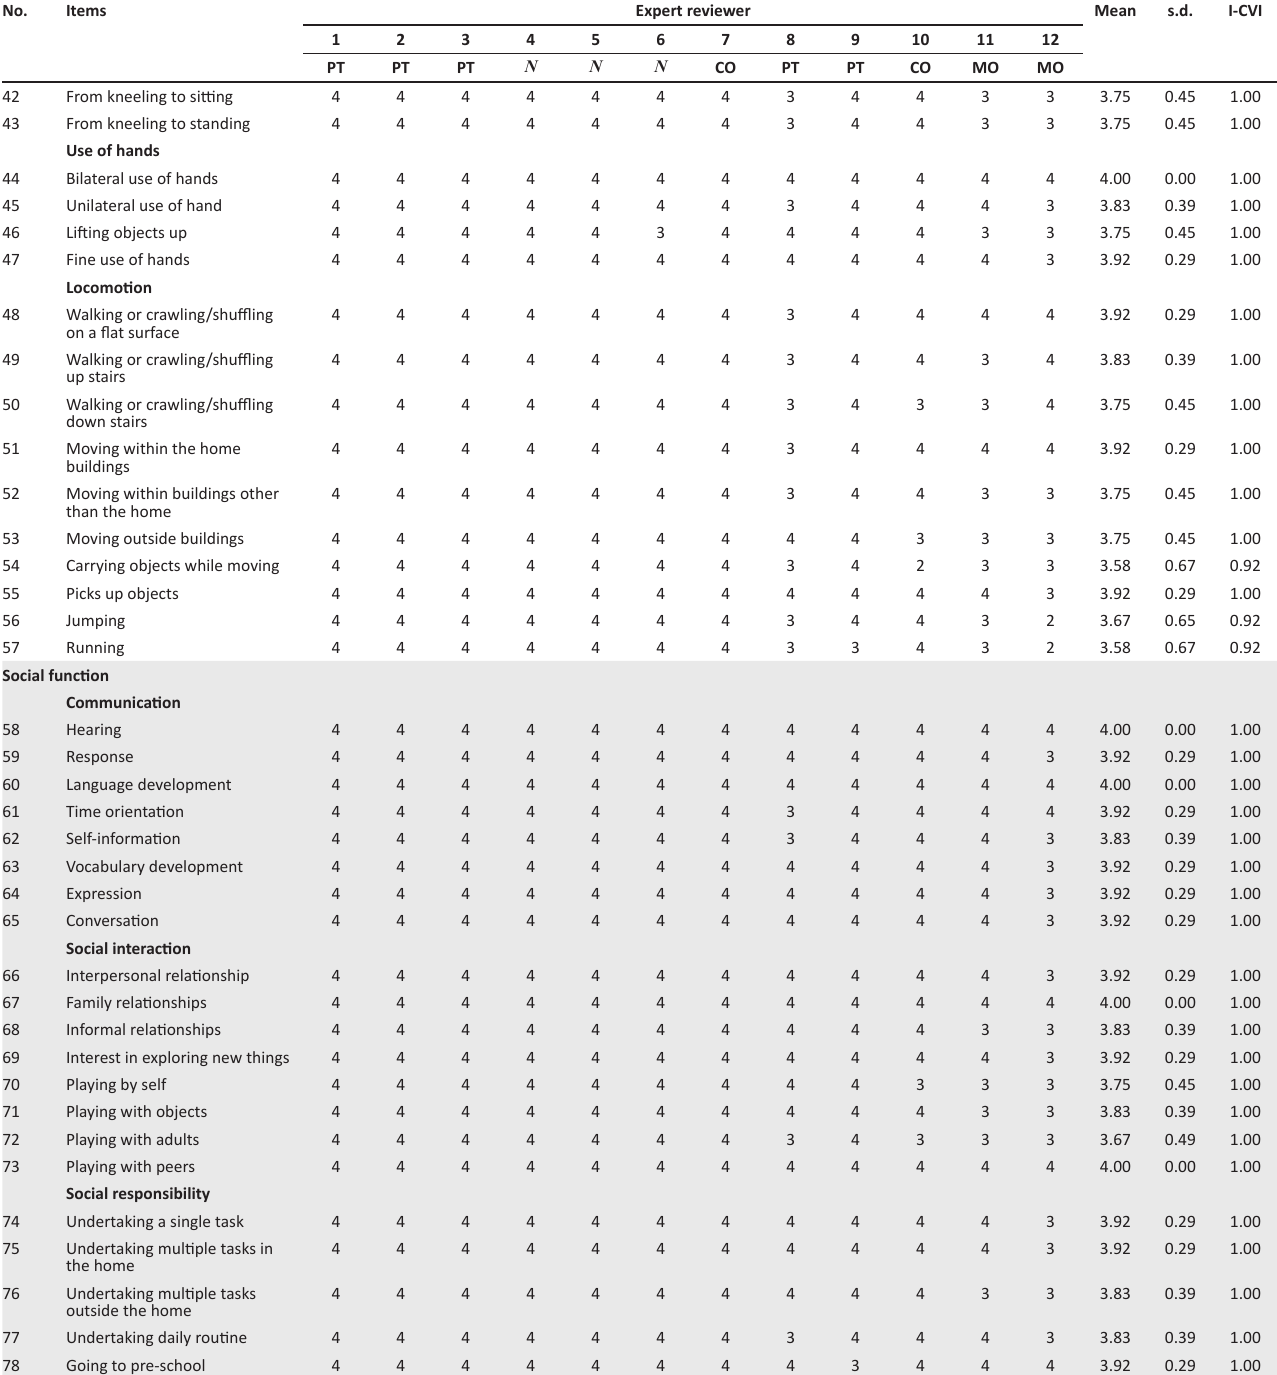
TABLE 7 (Continues...): Frequencies of ratings by the expert clinicians and Item Content Validity